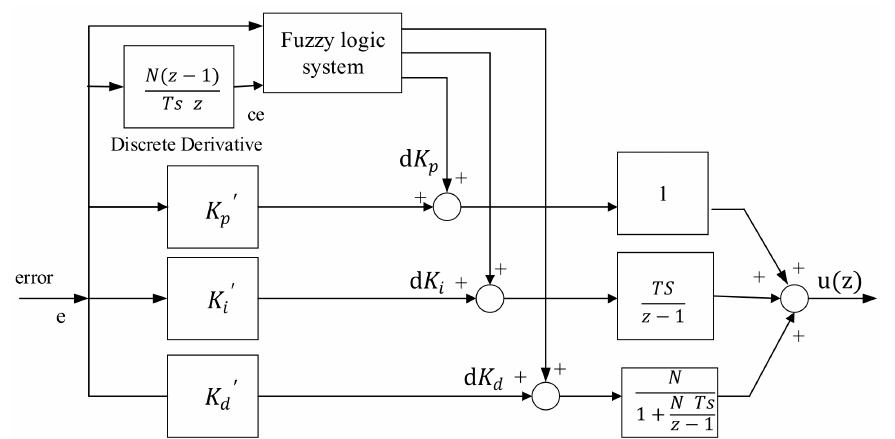
Figure 10. Block diagram of self-tuning nonlinear fuzzy PID controller (Reprinted from refer- ence [119] with permission from Hammad, copyright